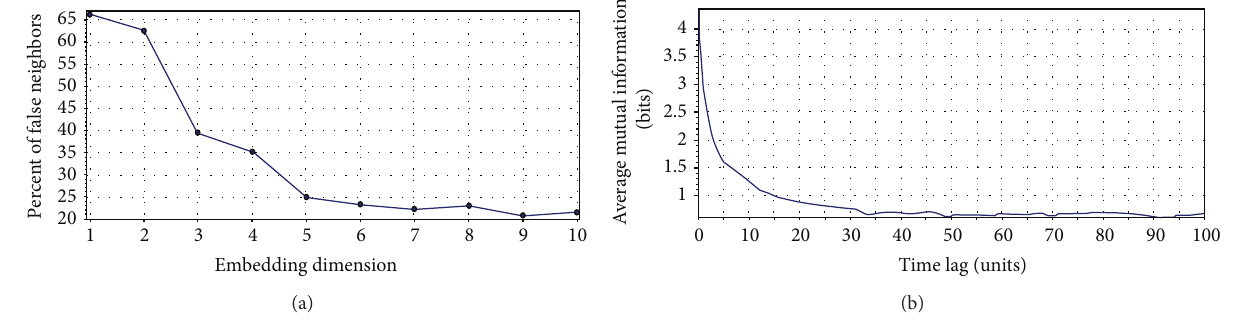
Figure 3: Optimal embedding dimension using FNN (a) and time delay using AMI